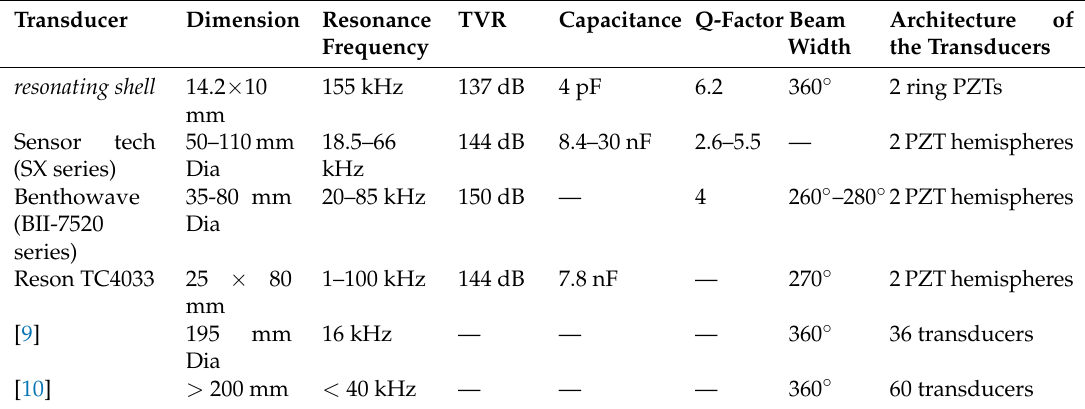
Table 4. The comparison between the resonating shell and state-of-art and commercial spherical- omnidirectional